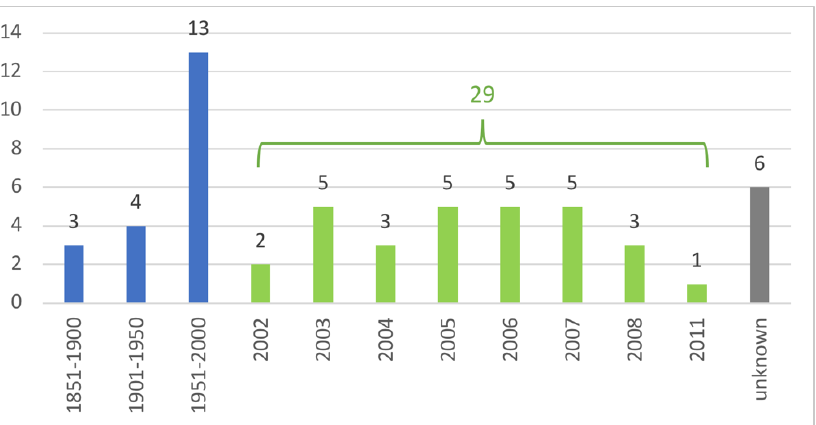
Figure 4. Companies that had jatropha projects in India by year of foundation (information on six companies was not available as they were already out of business at the time of research with no company record available); source: author survey.